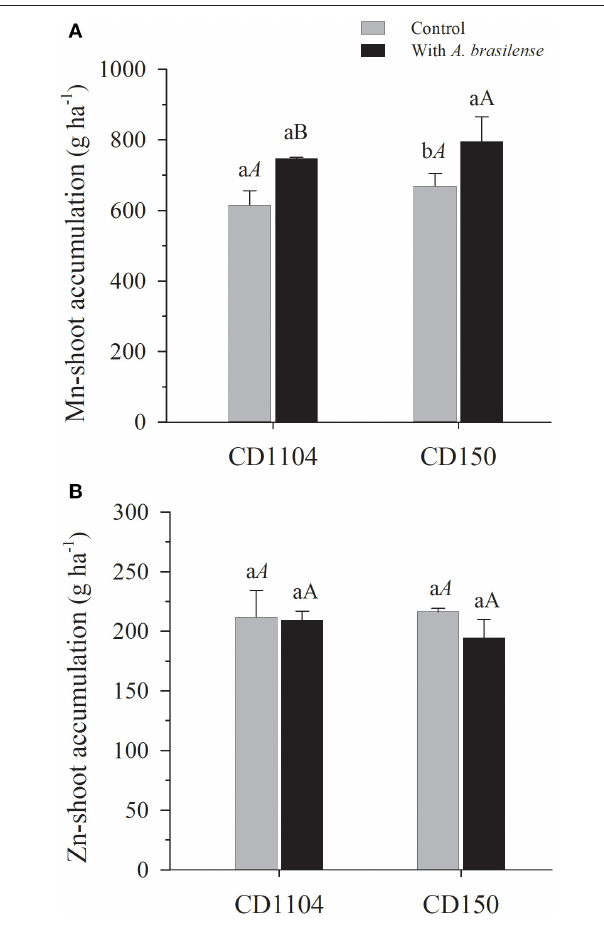
FIGURE 5 | Effects of inoculation with A. brasilense on the shoot of the wheat cultivars CD1104 and CD150 in the nutritional accumulation of Mn (A) and Zn (B) . Different letters indicate difference between means according to a Tukey test ( p ≤ 0.05). Lowercase letters correspond to cultivars within each inoculation level, and uppercase letters correspond to inoculations within each cultivar level. Identical letters do not differ from each other according to a Tukey test ( p ≤ 0.05). CV (%) = 9.8 (A) and 10.8 (B) . Error bars indicate the standard error of the mean ( n = 6 replications).